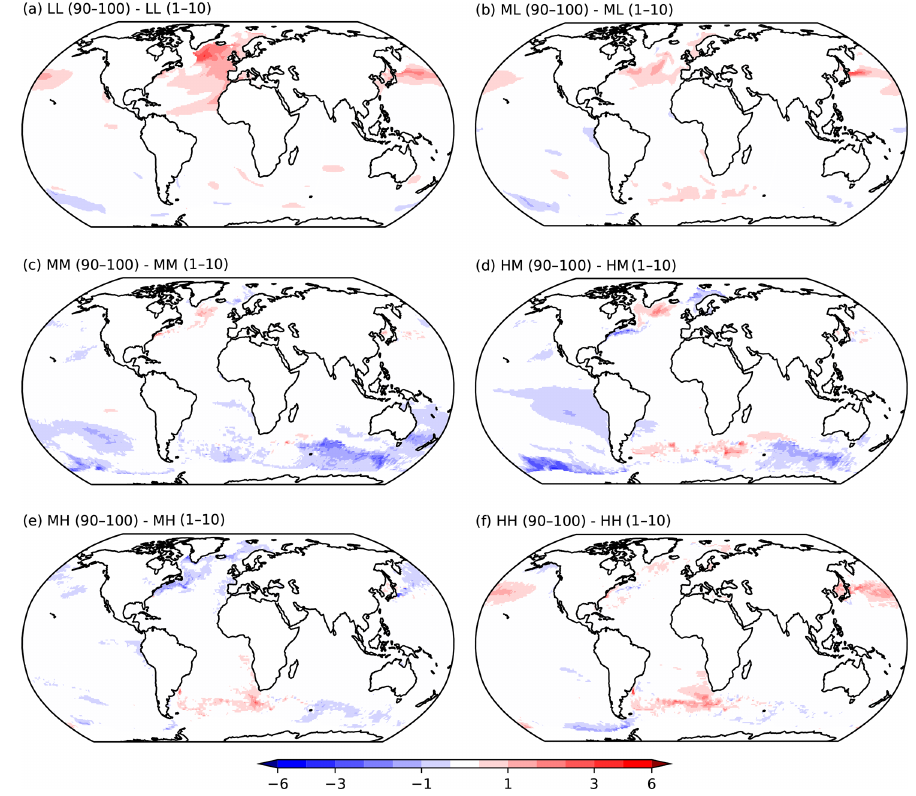
Figure 8. The change in SST over 100 years of the control-1950 simulation illustrated by the difference between years 90–100 and years